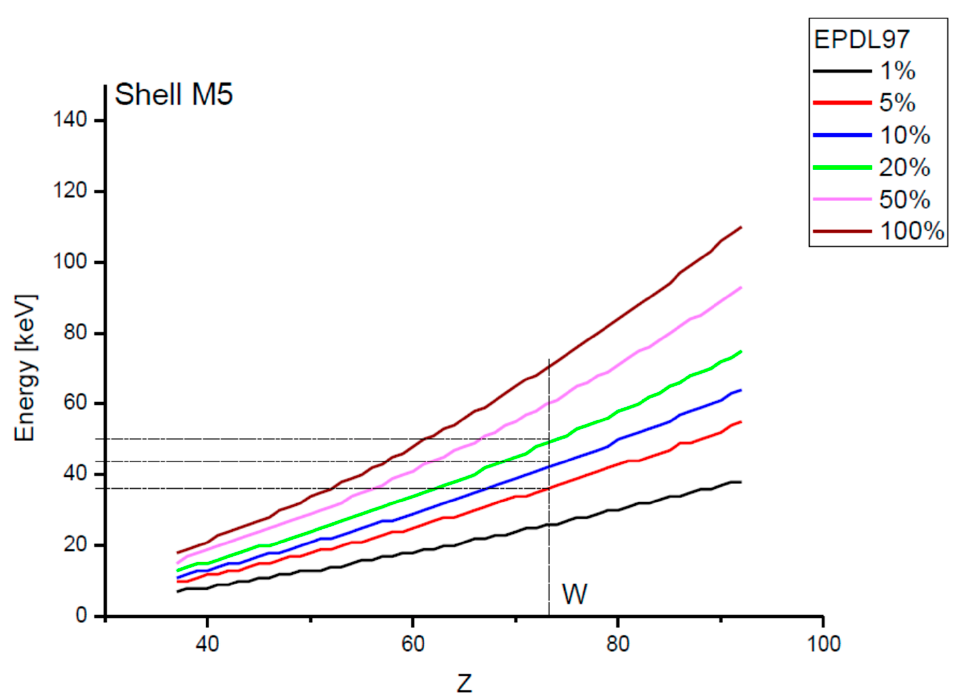
Figure 4. Values of the energy in keV as a function of the atomic number Z, for which the ratio σ M5/ τ M5 became larger than 1%, 5%, 10%, 20%, 50%, and 100%. These values were computed using the EPDL97 database. This shows the extent of the correction for the W lines of M5, α 1, and α 2 when the exciting source was around 50 keV.